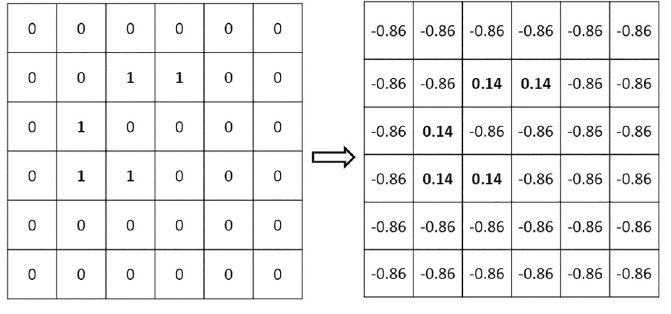
Fig 7. Data Centralization